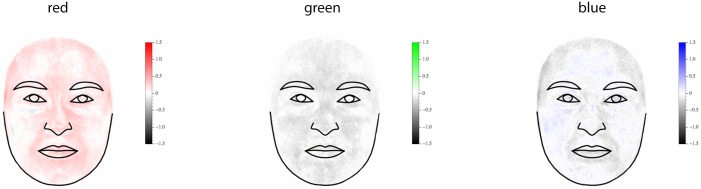
Regression of facial texture on BMI, visualized for each color channel (R, G, B) separately.In contrast to Fig 5, here the RGB values of each pixel were corrected to keep brightness constant (i.e., they were mean-centered separately for each pixel) to focus on the association of hue with BMI.